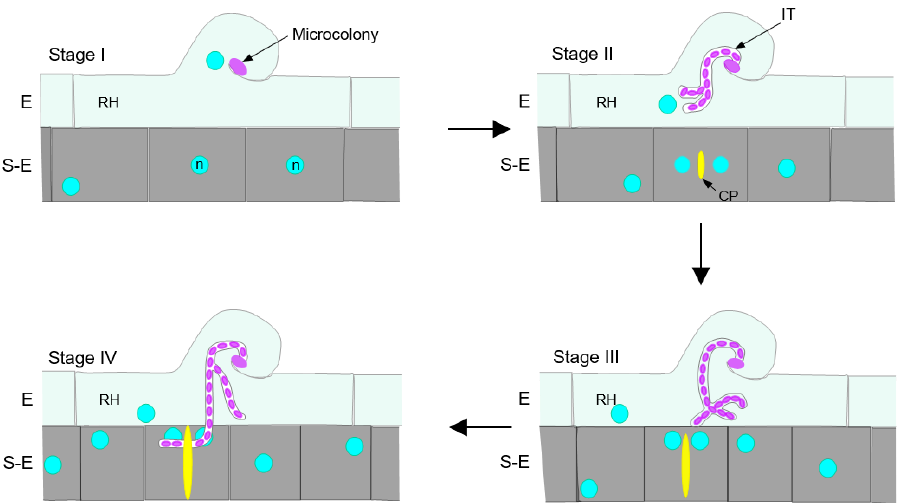
Figure 6. Schematic representation of the dynamics between the infection thread (IT) progression and the reactivation of the cell cycle. Infection thread (IT) progression was divided in stages I – IV, in which cells become successively shorter. Stage I: Rhizobia (magenta) is forming a microcolony, and the cell nucleus (circles in blue) is mainly at the center of the cell. No cell plate (CP, in yellow) is distinguished. Stage II: IT is formed and branched. A nascent CP is observed when the IT tip is close in the body of the RH. Stage III: the tip of the IT reaches the base of the RH and the CP use to be at the end of expansion process, suggesting a late cytokinesis in expansion. Stage IV: the IT has penetrated an adjacent subepidermal (S-E) cell and may cross the CP that is fully expanded, indicative of a post-cytokinetic status. E, epidermis.